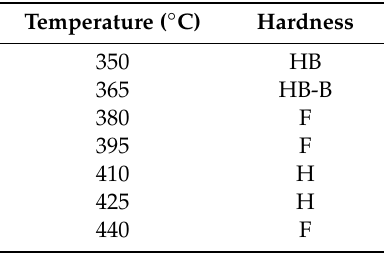
Table 2. Hardness of the PTFE coatings, without texturization, at different curing temperatures